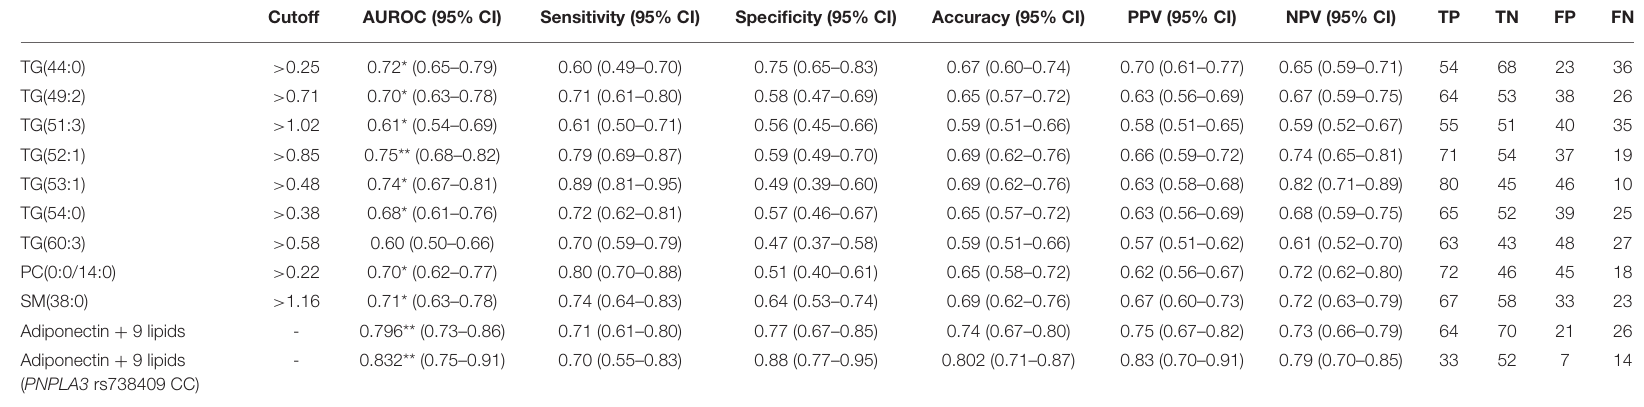
Applied in the validation cohort, n = 181; PNPLA3 rs738409 CC carriers, n = 106. NASH is considered as positive if the levels of each parameter are superior or inferior to the cutoff value as indicated; for adiponectin, < 7.32 µ g/ml. p-values corrected with Benjamini–Hochberg procedure, assuming 5% false discovery rate. CI, confidence interval; FN, false negative; FP, false positive; NAFL, nonalcoholic fatty liver; NASH, nonalcoholic steatohepatitis; NPV, negative predictive value; PC, phosphatidylcholine; PPV, positive predictive value; TG, triglyceride; TN, true negative; TP, true positive; SM, sphingomyelin. * p < 0.05; ** p <